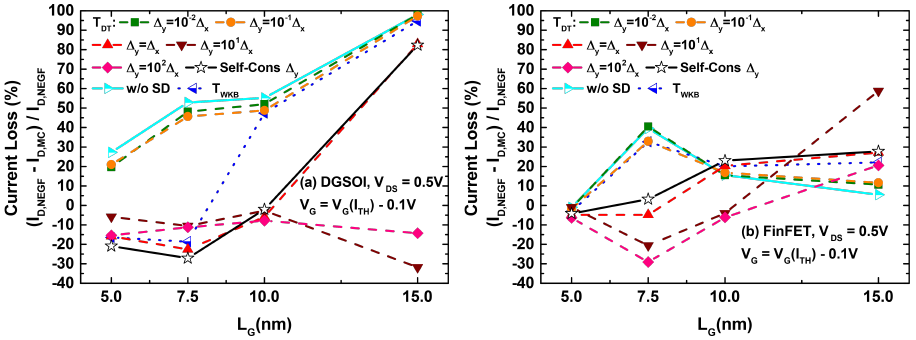
Figure 7. Subthreshold current loss as a function of L G in the DGSOI ( a ) and FinFET ( b ) between NESS and MS-EMC with the different implementations of the tunneling probability in the